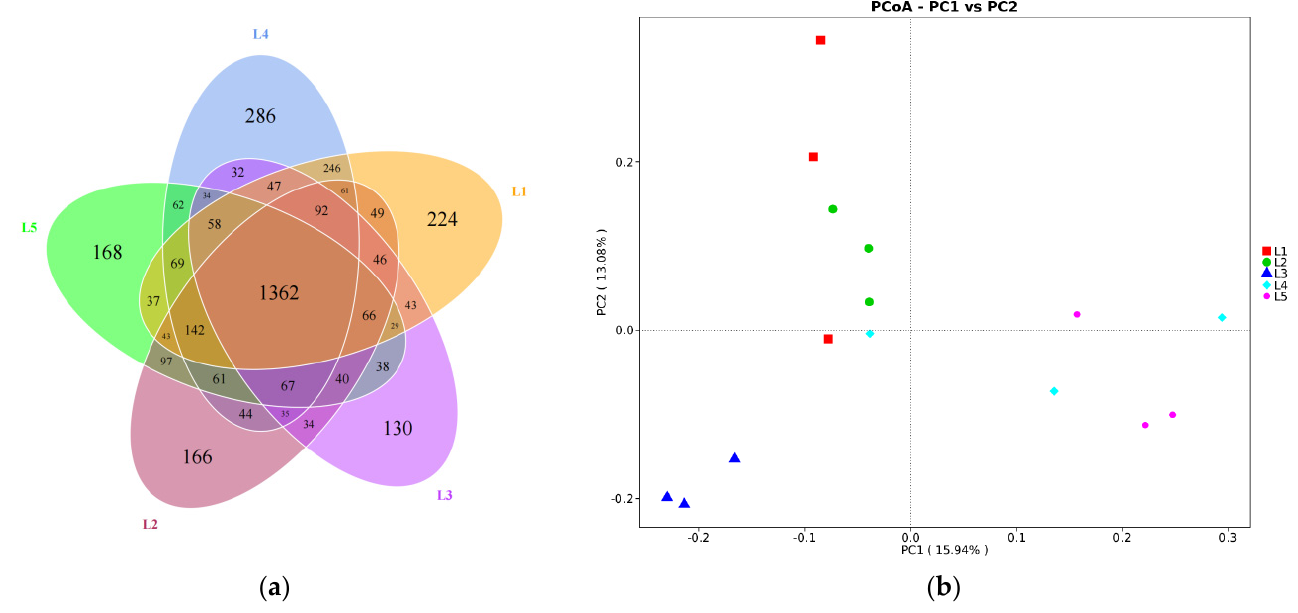
Figure 1. Petal diagrams ( a ) of OTUs for the rumen of the lamb. PCoA ( b ) plot based on the Bray– Curtis dissimilarity of the microbiota ( p = 0.001). L1, L2, L3, L4, and L5 represent five groups of lambs treated with dietary alfalfa (AF) ratio at 0%, 20%, 40%, 60%, and 80% in the alfalfa–sweet sorghum (AF–SS) silage mixtures; n = 3 for each group.